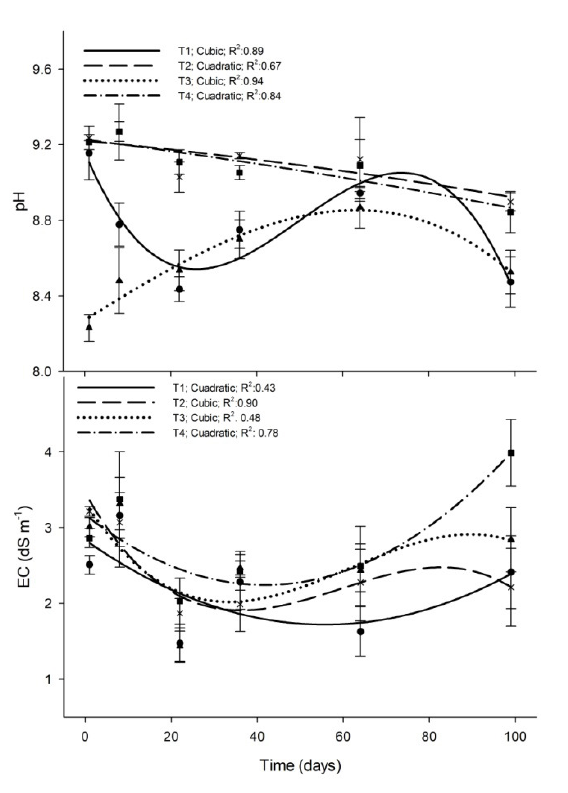
Figure 3: pH and Electrical conductivity (EC) of static piles (T1 ● prickly pear cactus+BP; T2 ᵡ moringa+BP; T3 ▲ prickly pear cactus; T4 ▀ moringa) over 100 days of analysis. Means (±SD) were calculated from five replicates for each treatment and sampling day. Statistically different (Tukey test,